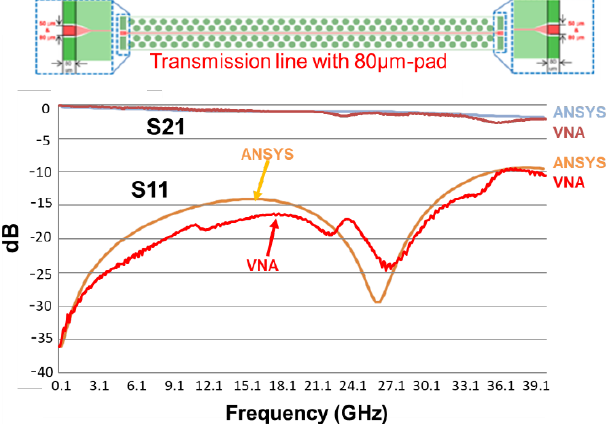
Figure 18. The VNA measurement results of test vehicle (50 μm pad) and correlation with ANSYS results.